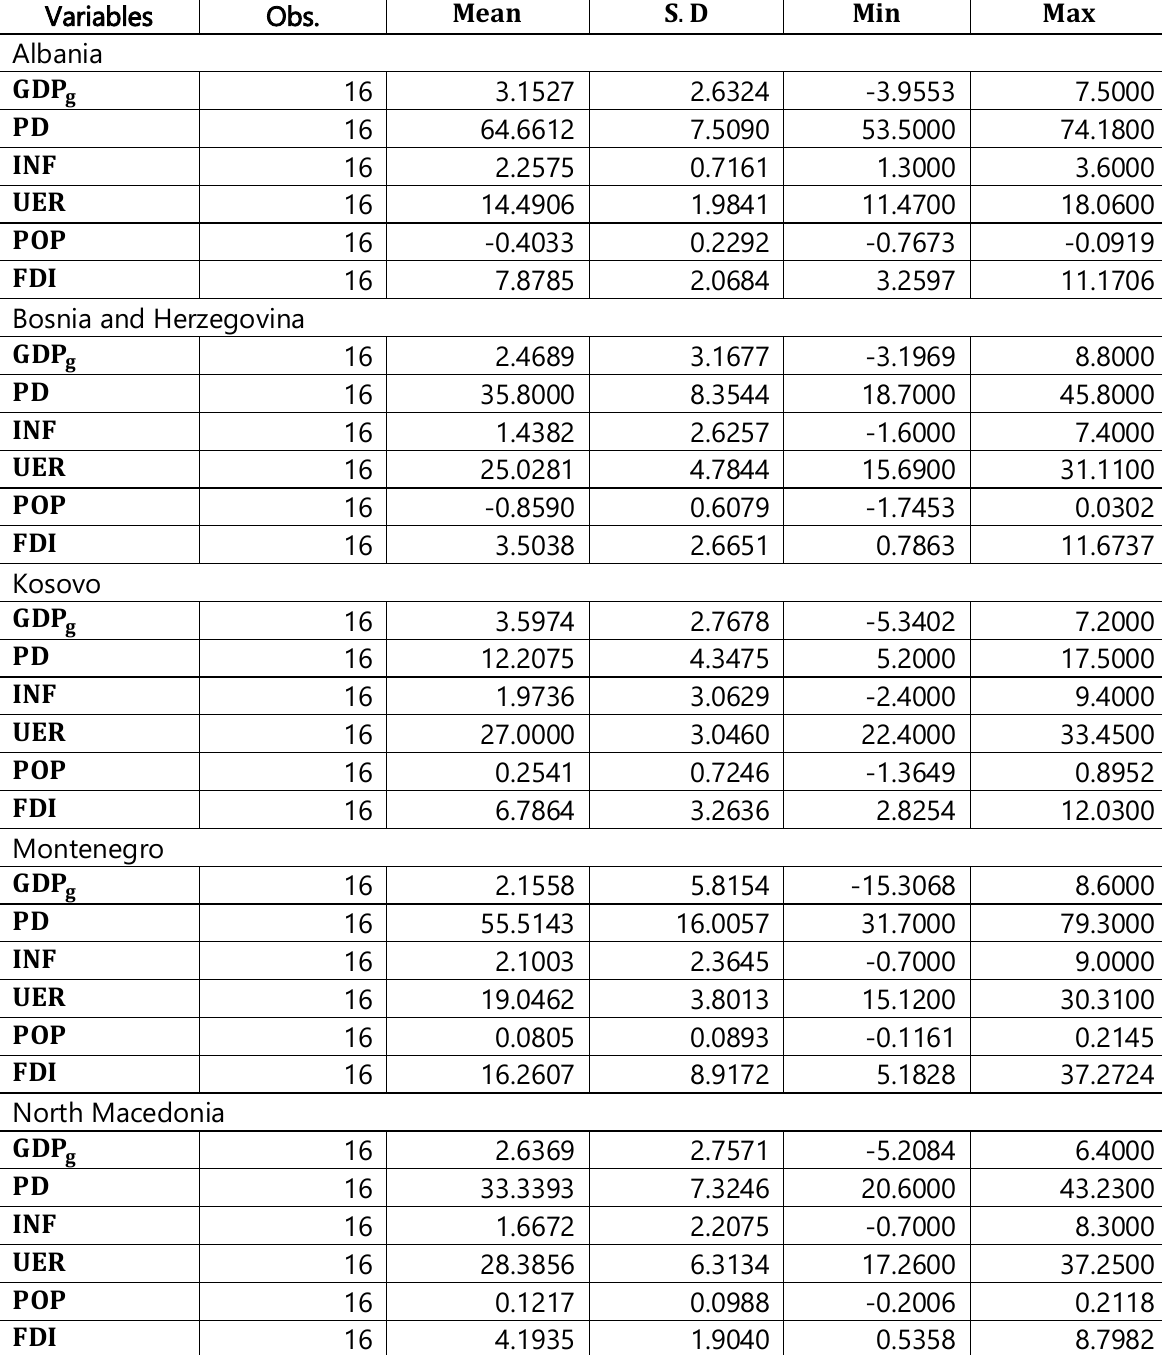
Table 2: Descriptive Analysis (Source: Authors’ calculation) Variables